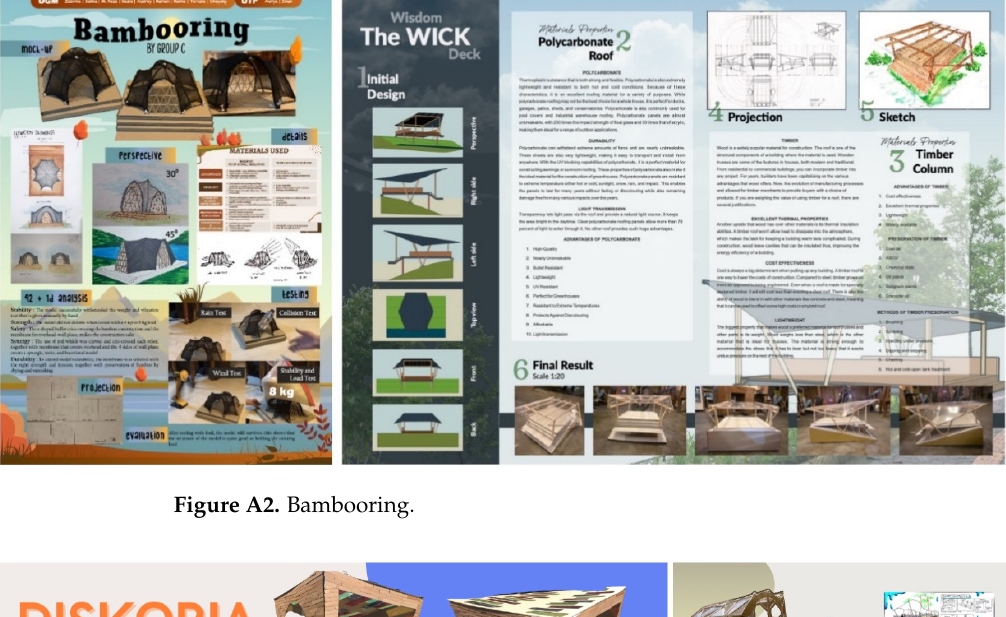
Figure A1. Under the leaf.